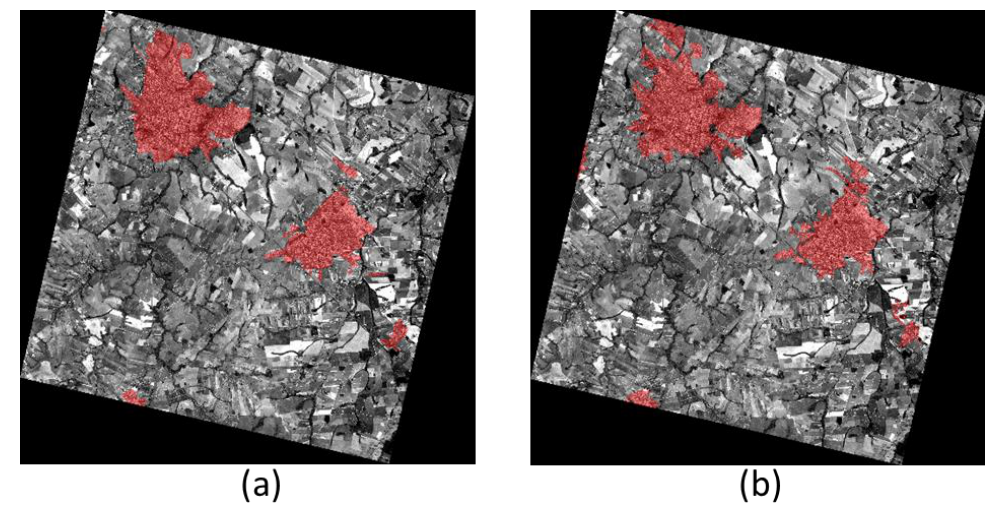
Figure 6. Aracatuba test site: ( a ) ―compact urban area‖ reference data set superimposed to the original CBERS-2B scene; ( b ) results of the proposed